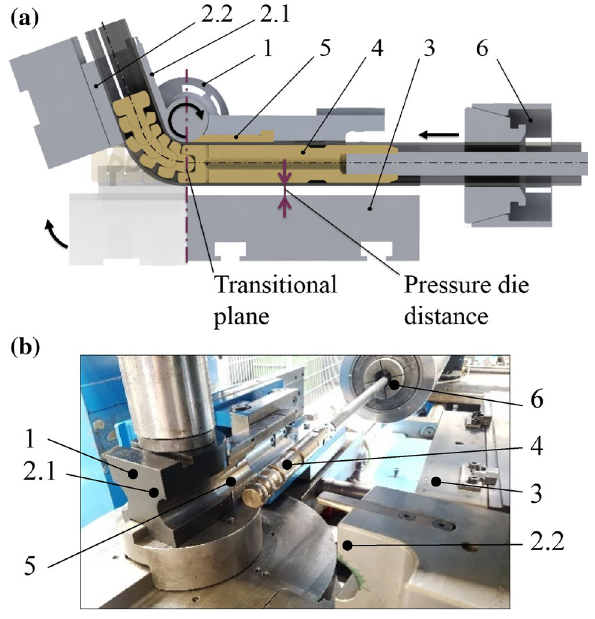
Fig. 1 a and b Tools of the rotary draw bending process Borch- mann et al.